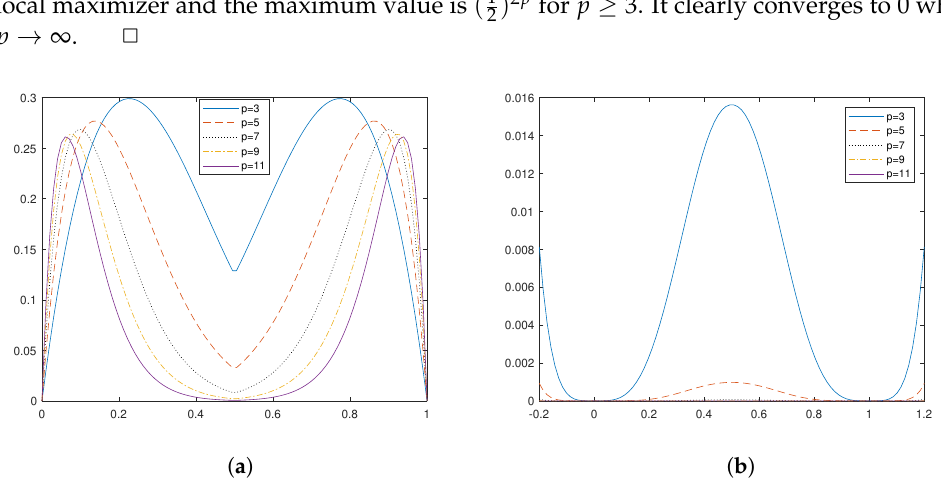
( x ) and σ p ( x ) with different values of p . ( a ) Local minimum and Figure 9. Graphs of τ p S − NR S − NR ( x ) ; ( b ) Local minimum and maximum of σ p maximum of τ p S − NR